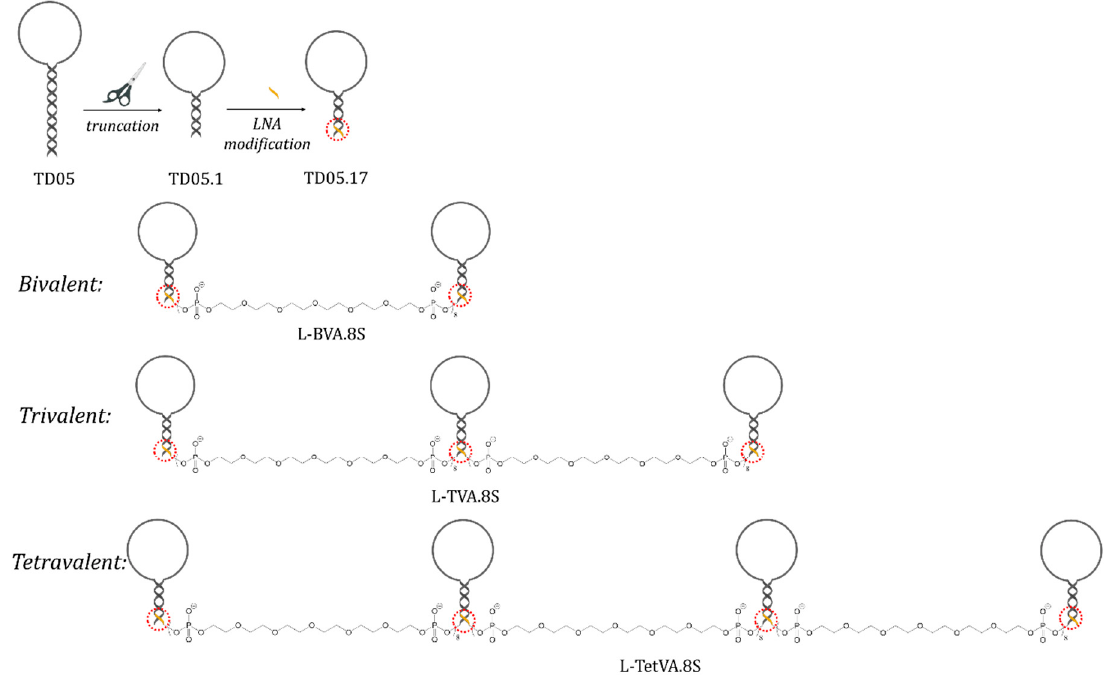
Figure 3. Evolution of TD05 aptamer. The previously reported TD05 aptamer was shortened with 10 nucleotides by truncation (TD05.1) and three bases have been changed to locked nucleic acid base pairs (TD05.17) (marked yellow in dashed, red circle). TD05.17 aptamers were cross-linked with PEG linkers to form bivalent (L-BVA.8S), trivalent (L-TVA.8S) and tetravalent (L-TetVA.8S) aptamers to improve